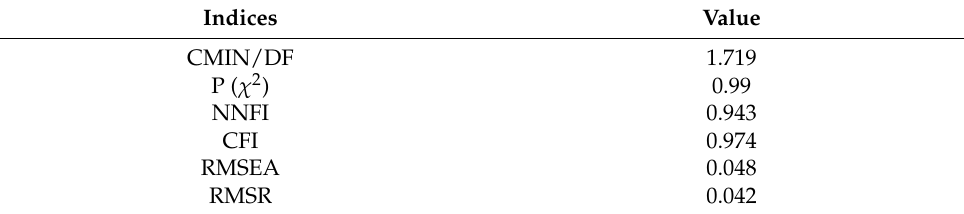
Table 5. CEFI-R questionnaire goodness-of-fit